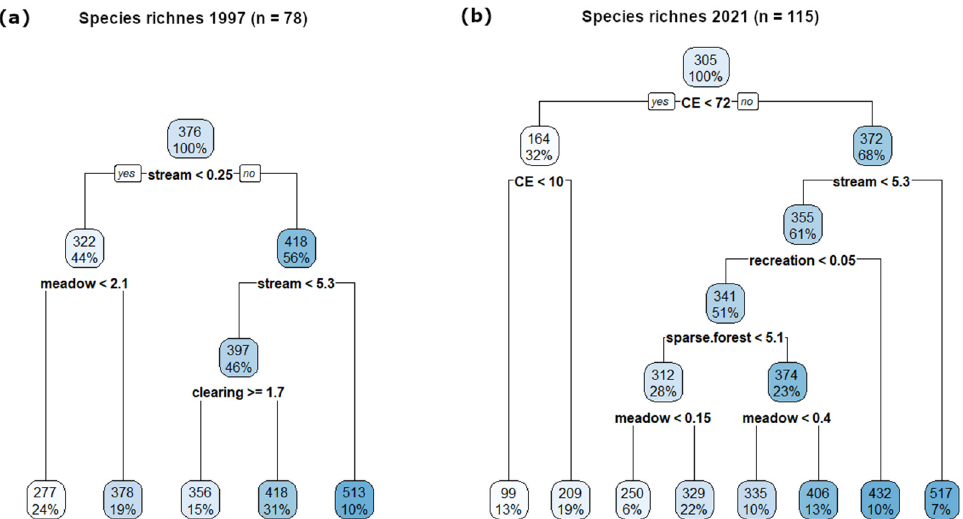
Figure 6. The regression trees for species richness in surveys in ( a ) 1997 (n = 78) and ( b ) 2021 (n = 115) based on the proportions (%) of individual land-cover categories per grid cells, landscape heterogeneity and proportions (%) of individual NPs and surrounding area, resp. surveyed area per grid cells (CE; within 2021). Numbers in each node represent the average of species richness in this node.